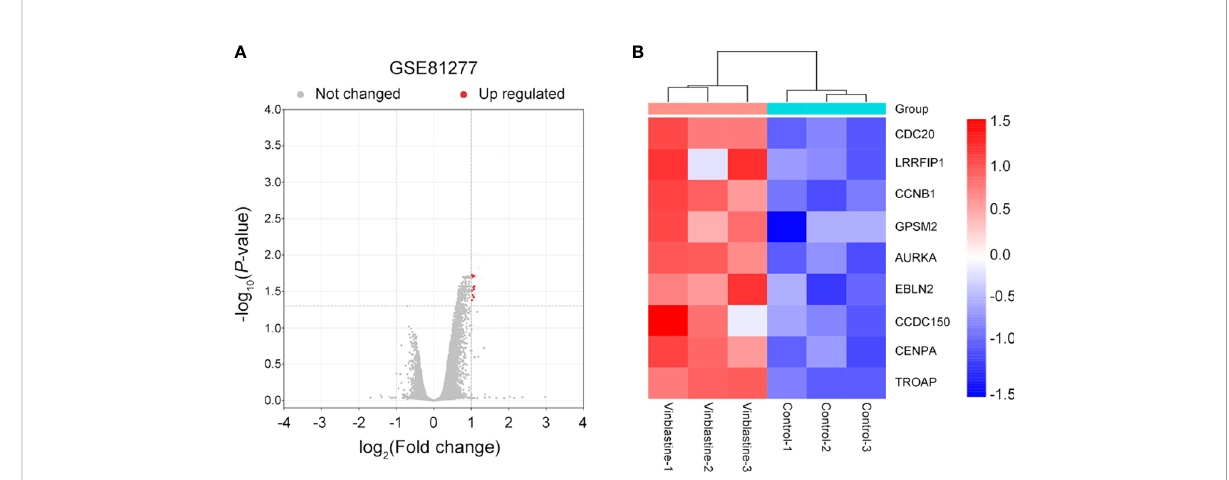
FIGURE 1 Nine vinblastine resistance-related genes were found from GSE81277. (A) The volcano map re fl ects the differently expressed genes in GSE81277. (B) The heatmap re fl ected the expression of nine hub genes in different datasets of